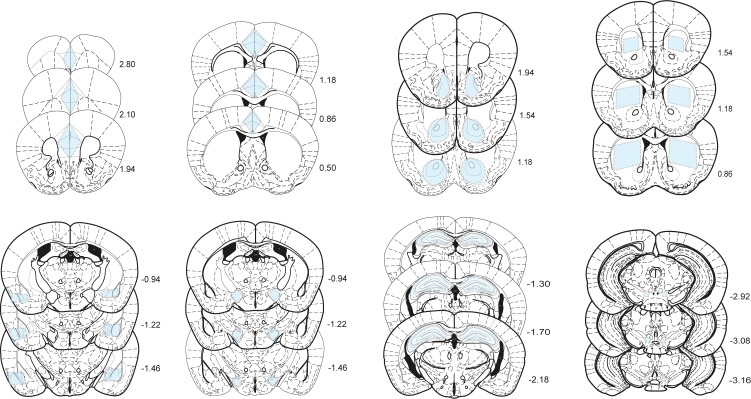
Boundaries of dissected structures.Shaded regions in blue represent areas cut out from 400 µm slices for LCtx (limbic cortex), NAc (nucleus accumbens), DS (dorsal striatum), Amy (amygdala), LH (lateral hypothalamus), and Hipp (hippocampus) and 200 µm slices for VTA (ventral tegmental area), providing reproducible tissue samples for analysis of transcription. Distance from Bregma on the rostral-caudal axis is indicated in mm.